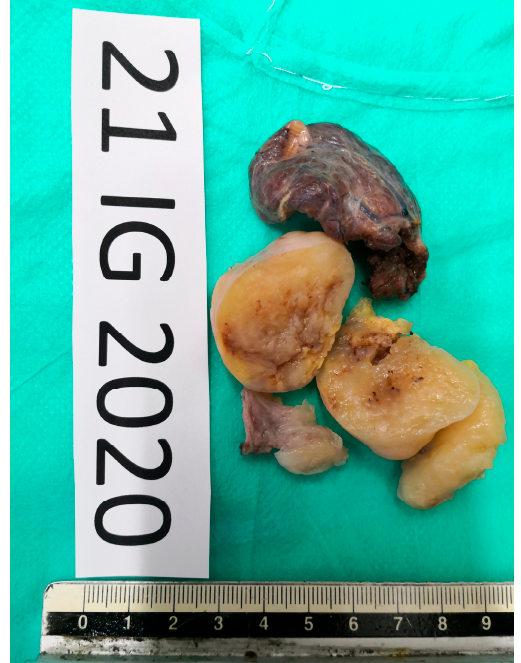
Figure 5. Definitive pathology showing mesenchymal proliferation, spindle-cells type, with both dense and loose areas with thickened walls vases at hematoxylin and eosin staining. In dense areas (Antoni A), the so-called “Verocay bodies” were evident, while in the loosest areas (Antoni B), they appeared evident diffuse nuclear atypia.